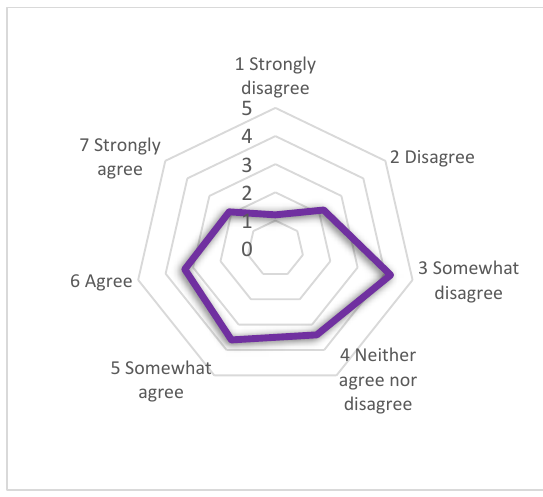
Figure 21. Usability assessment.